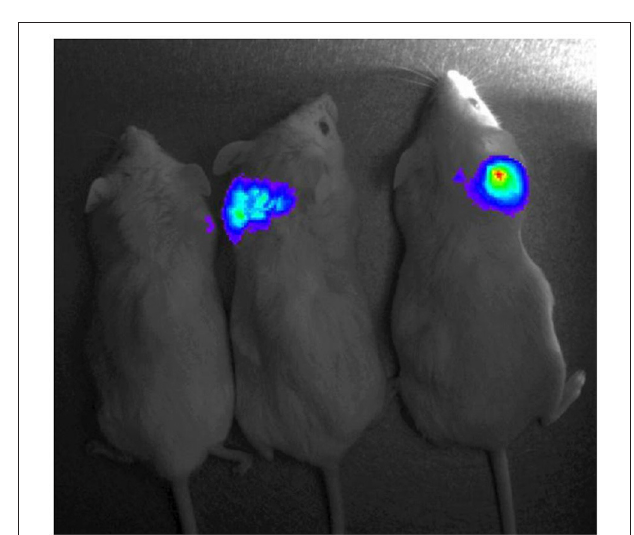
FIGURE 6 | In vivo test of N -Z-DEVD-aLuc. N -Z-DEVD-aLuc (100 mg/kg, i.p.) was administered to all SCID mice previously inoculated with U87-Luc glioblastoma cells (middle) . Apoptosis was induced by Ac-915 in all mice except negative controls administered by PBS (left) . Aminoluciferin was used as positive control (right)